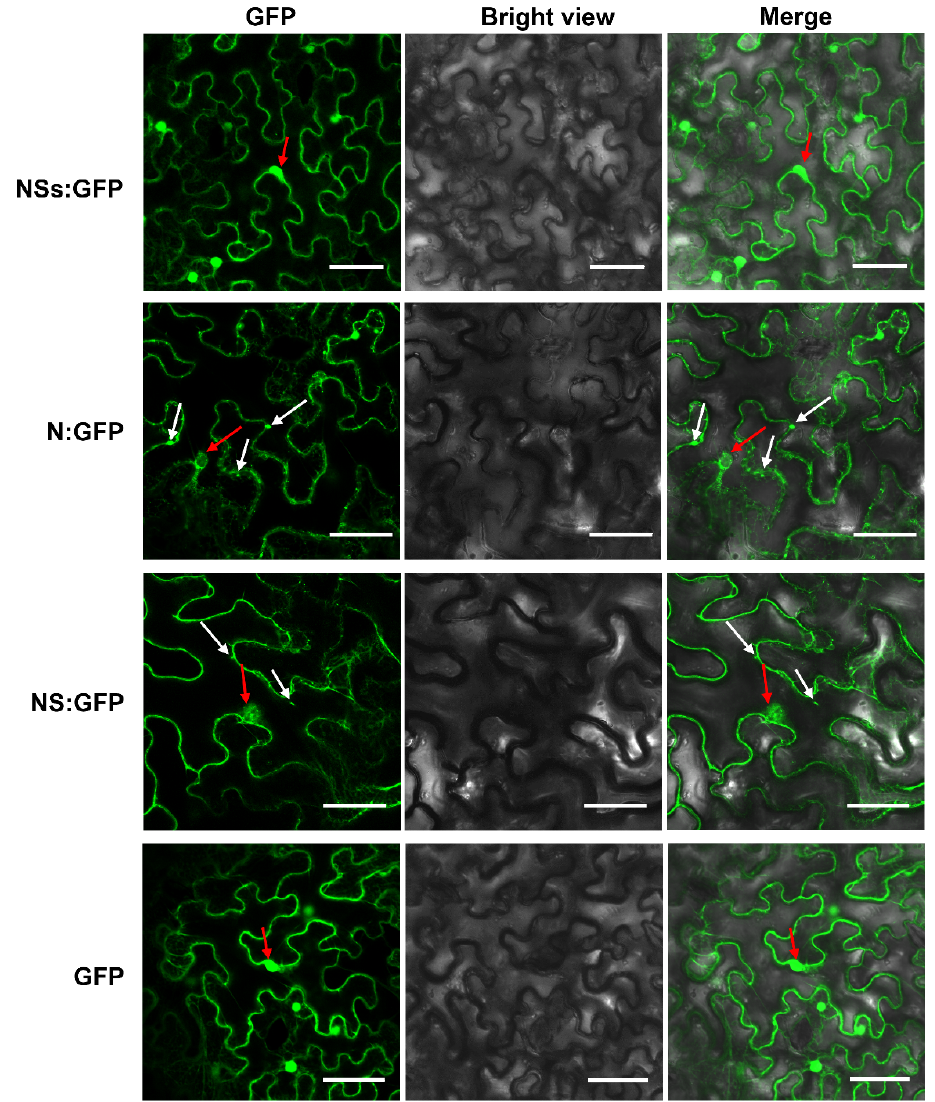
Figure 5. Subcellular localization analyses of RDaBV NSs, N, and NS proteins. N. benthamiana leaves were infiltrated with A. tumefaciens EHA105 harboring NSs-GFP, N-GFP, NS-GFP, or GFP construction. Scale bars, 50 µm. White arrows indicate GFP aggregates, while red arrows indicate nuclei.